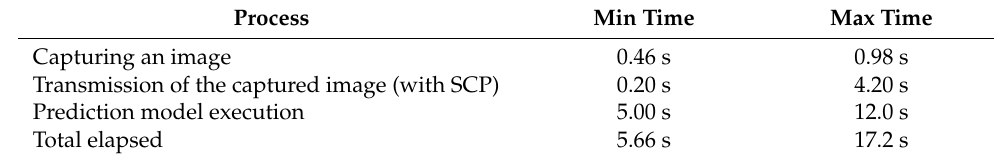
Table 2. Cycle times corresponding to the primary process blocks with respect to the detection system. Process Capturing an image